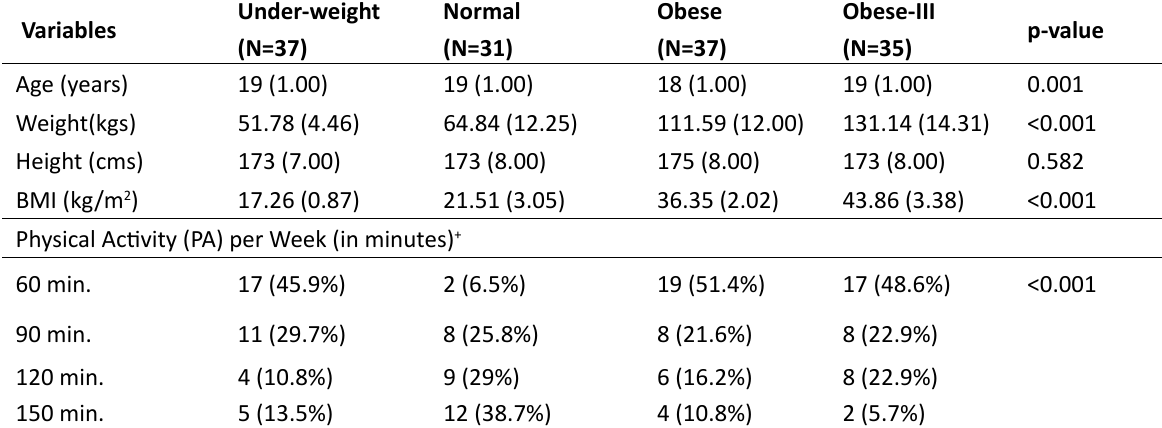
Table 1. Description of Physical Characteristics of Participants Variables